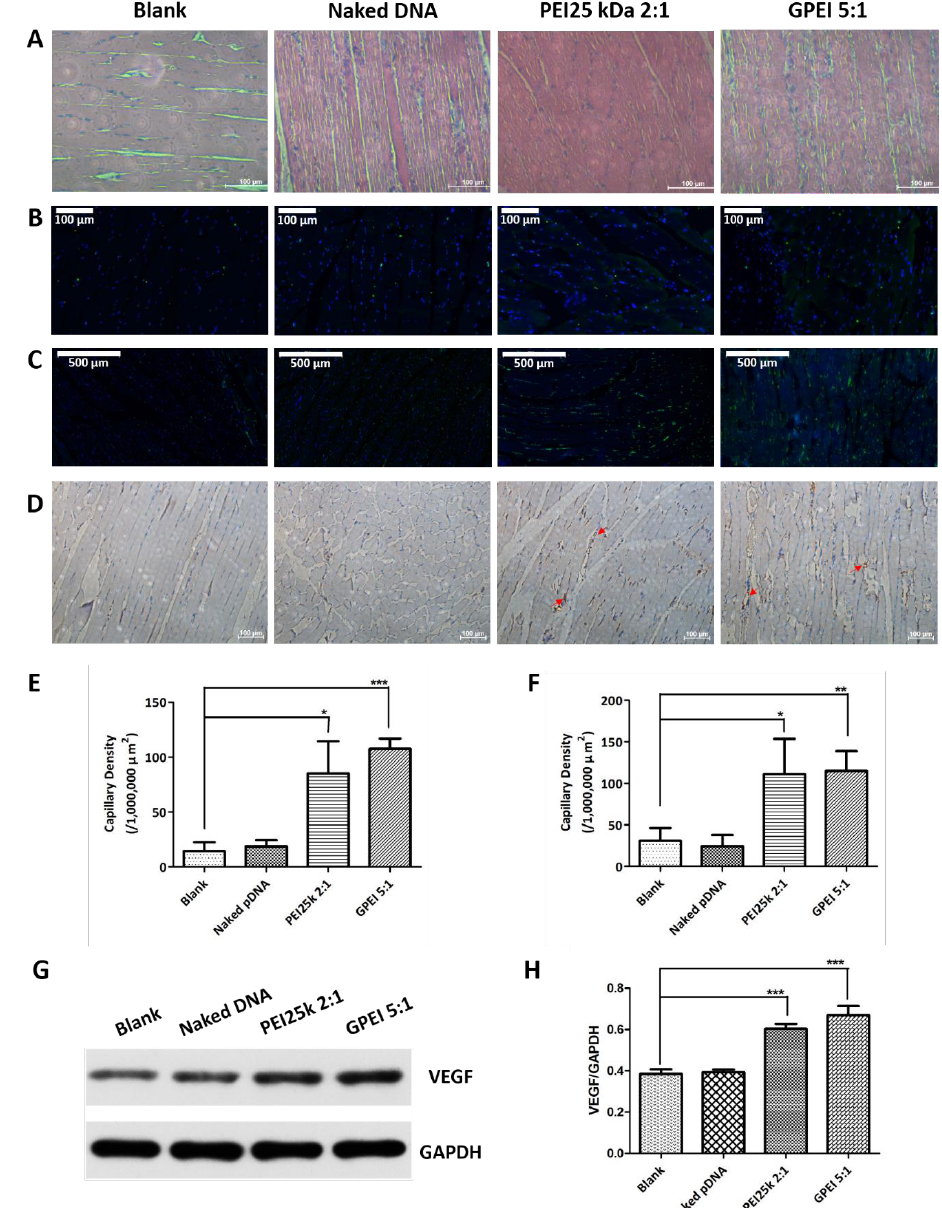
Figure 8. Neovascularization of gastrocnemii. ( A ) HE-staining images of gastrocnemii. Bar = 100 μm. ( B ) 5-Bromo-2-deoxyUridine (BrdU) immunofluorescence staining images of gastrocnemii (blue: DAPI; green: BrdU+). Bar = 100 μm. ( C ) CD34 immunofluorescence staining images of gastrocnemii (blue: DAPI; green: CD34+). Bar = 500 μm. ( D ) CD31 immunohistochemical staining images of gastrocnemii (brown, red arrows: CD31). Bar = 100 μm. ( E / F ) Image Pro Plus was used to conduct quantitative analysis of the capillary density of gastrocnemii ( E : CD34, F : CD31). ( G ) The Western blotting analysis of gastrocnemius muscles. ( H ) Image J was used to conduct quantitative analysis of vascular endothelial growth factor (VEGF) levels of gastrocnemii. Data are presented as mean values ± S.D. ( n = 4, *: p < 0.05, **: p < 0.01, ***: p < 0.001).